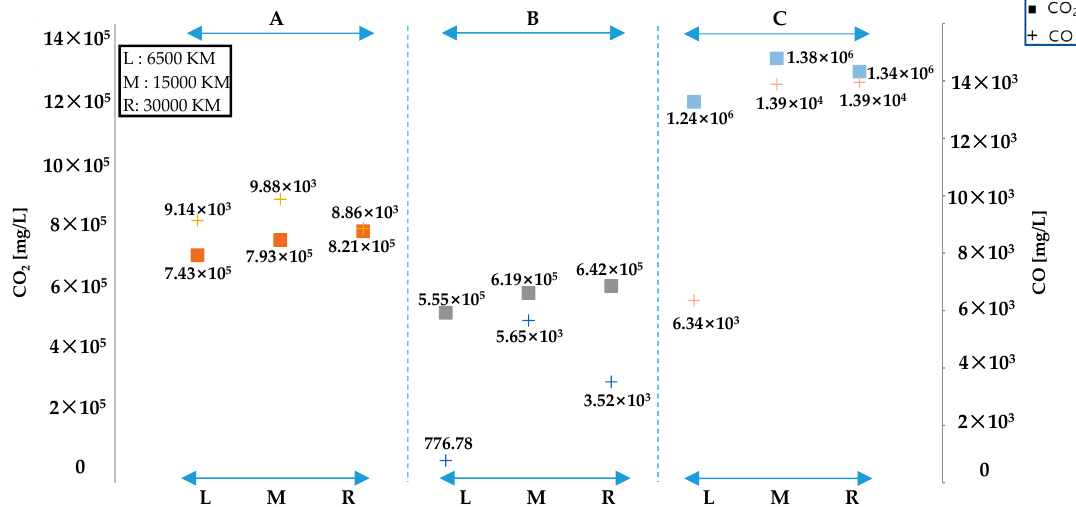
Figure 12. Total amount of CO 2 and CO discharged during acceleration regions in the highway mode of the US06 driving cycle.